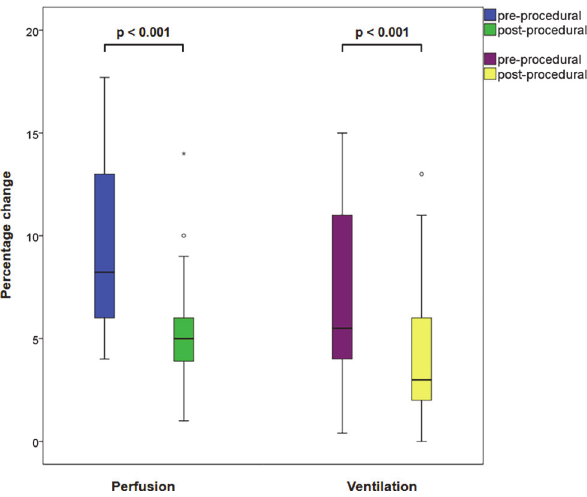
Fig 2. Boxplot of ELVR-mediated changes in target zone perfusion and ventilation.